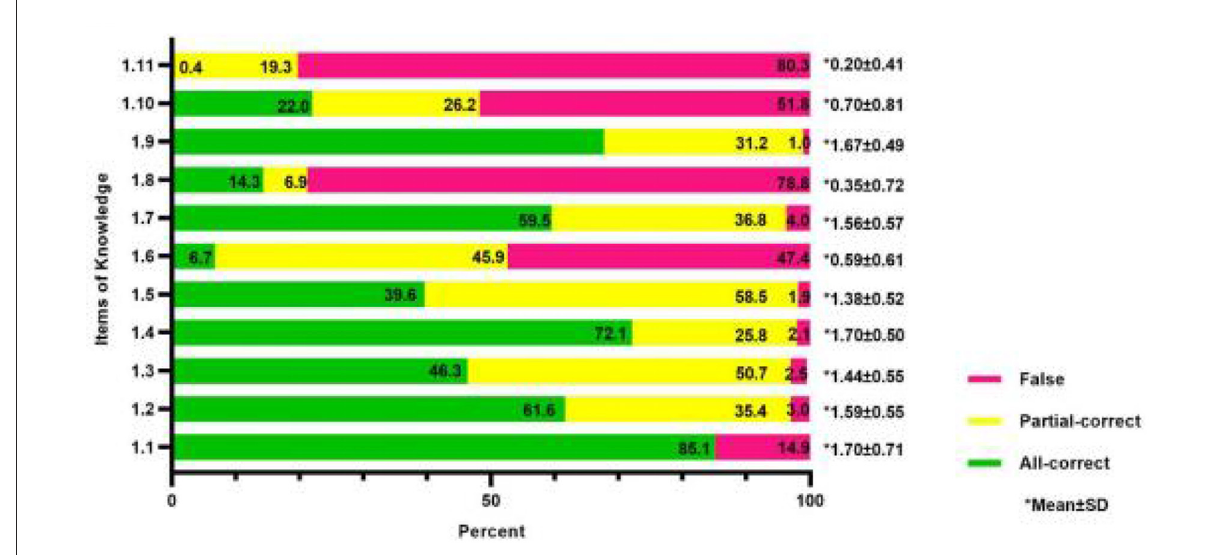
FIGURE1 Knowledge score of delirium and subtype assessment for clinical nurses ( n = 477).